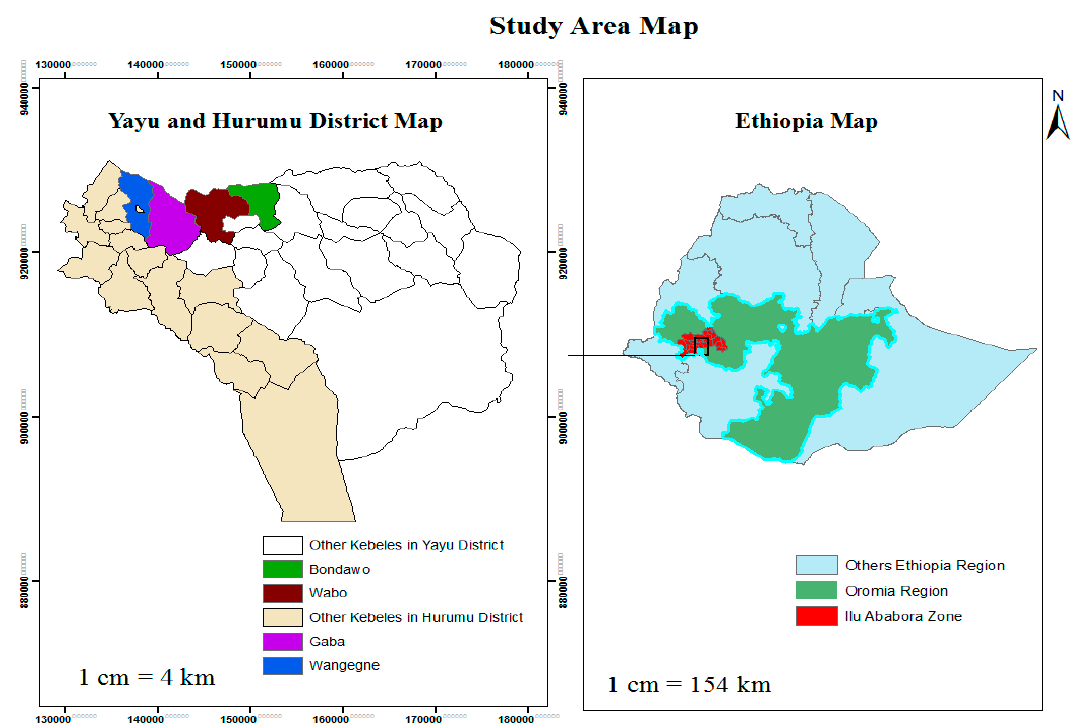
Figure 1. Map of study area; Yayo and Hurumu Woreda .